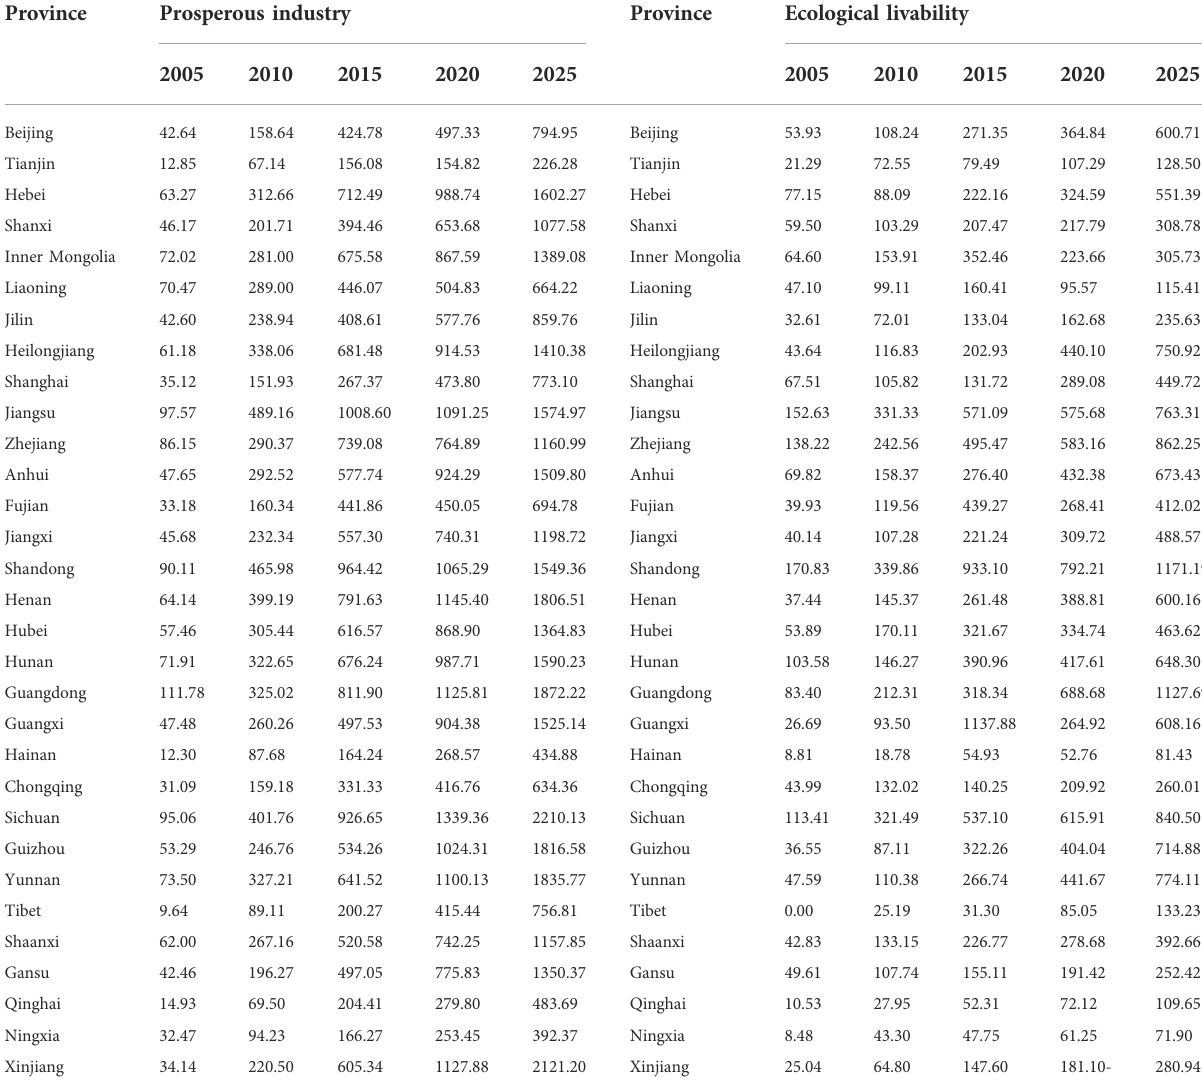
TABLE 4 Financial Expenditure on Industrial Prosperity-Ecological Livability in 31PLAD (Unit: 100 million). Province Prosperous